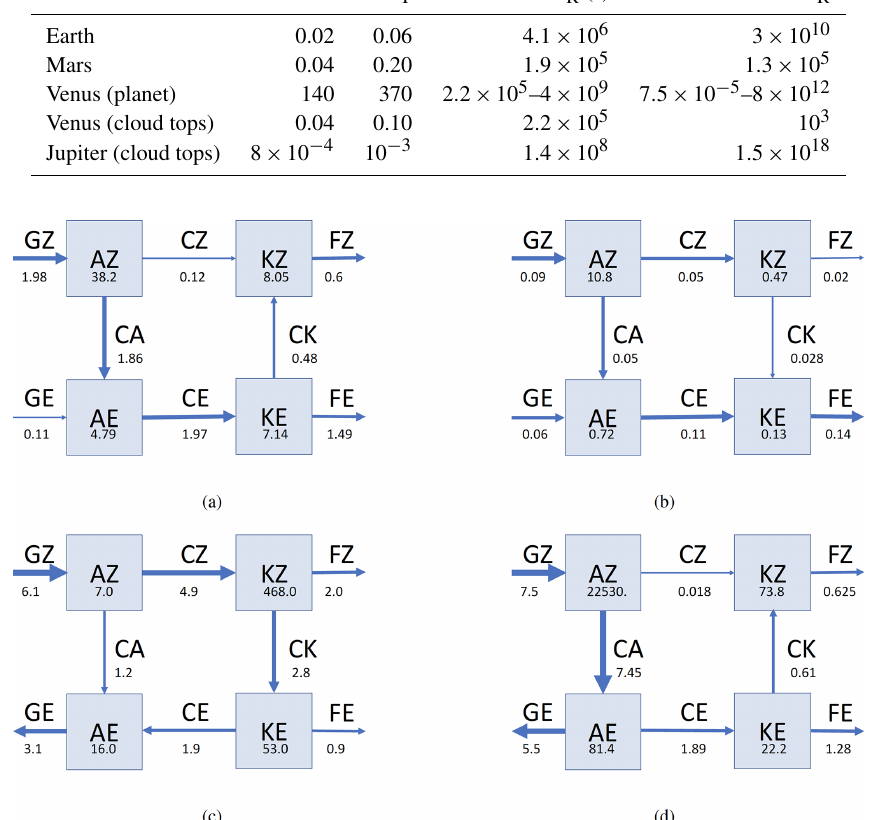
Figure 12. Representations of energy storage and interconversions in the form suggested by Lorenz (1955, 1967) for a selection of the main planets of the solar system: (a) Earth (calculations from Boer and Lambert, 2008); (b) Mars (calculations from Tabataba-Vakili et al., 2015); (c) Venus (calculations from Lee and Richardson, 2010) and (d) Jupiter’s weather layer (from preliminary calculations using a higher- resolution version of the model described in Young et al., 2019a). As before, energy reservoirs are shown in units of 10 5 joules per square metre, and conversion rates and source/sink terms are in units of watts per square